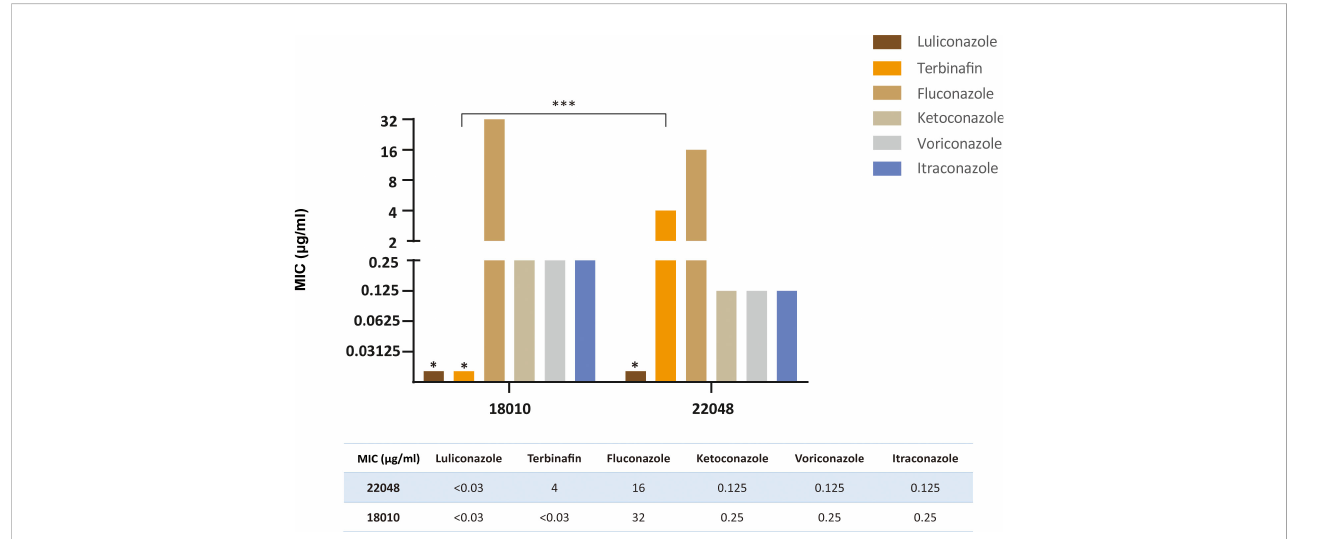
FIGURE 7 Comparison of MIC values of two strains (JYP22048 and JYP18010) to six antifungal agents. (*** means P<0.01, * means MIC<0.03 mg/L).